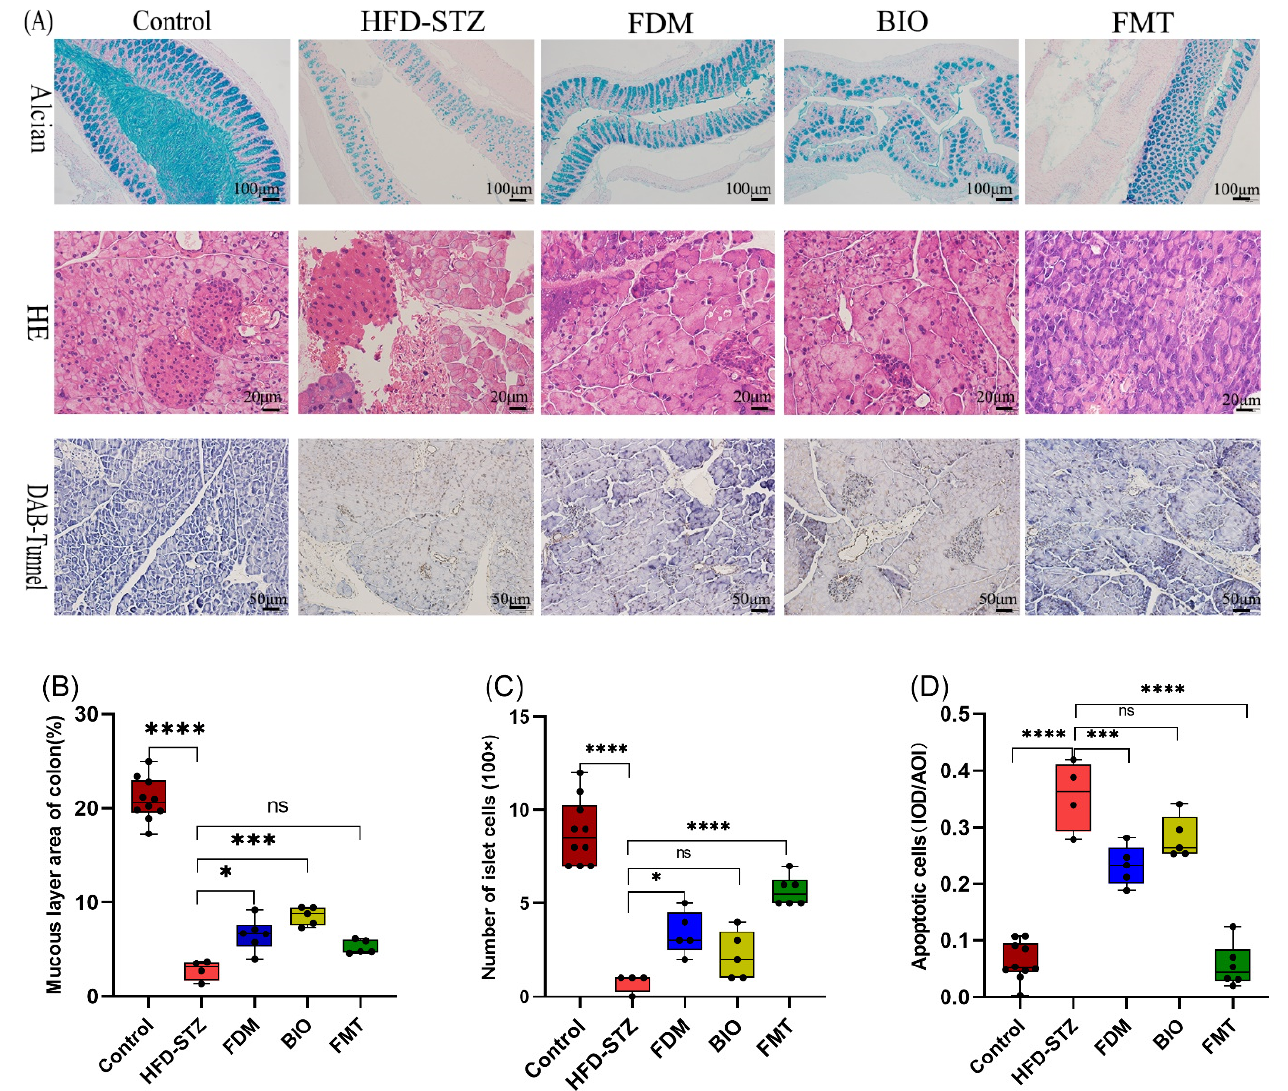
Figure 3. Effects of bacterial transplantation on colon and pancreas tissue. ( A ) Colon Alcian blue staining (100 × ), pancreas hematoxylin and eosin (HE) staining (400 × ), and pancreas TUNEL